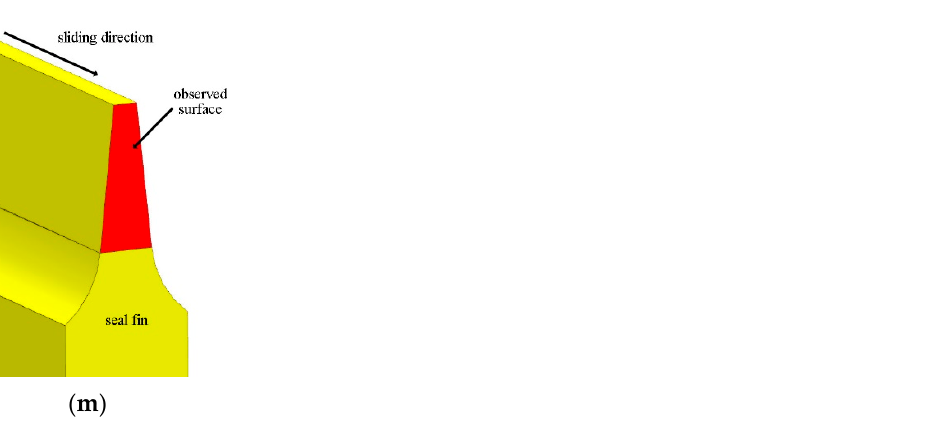
Figure 12. The cross-section of the seal fin. ( a , b ) The original seal fin; ( c , d ) only radial rub; ( e , f ) 60 μ m/s; ( g , h ) 80 μ m/s; ( i , j ) 100 μ m/s; ( k , l ) 120 μ m/s; ( m ) the observed surface; ( a , c ) are cited from reference [16].